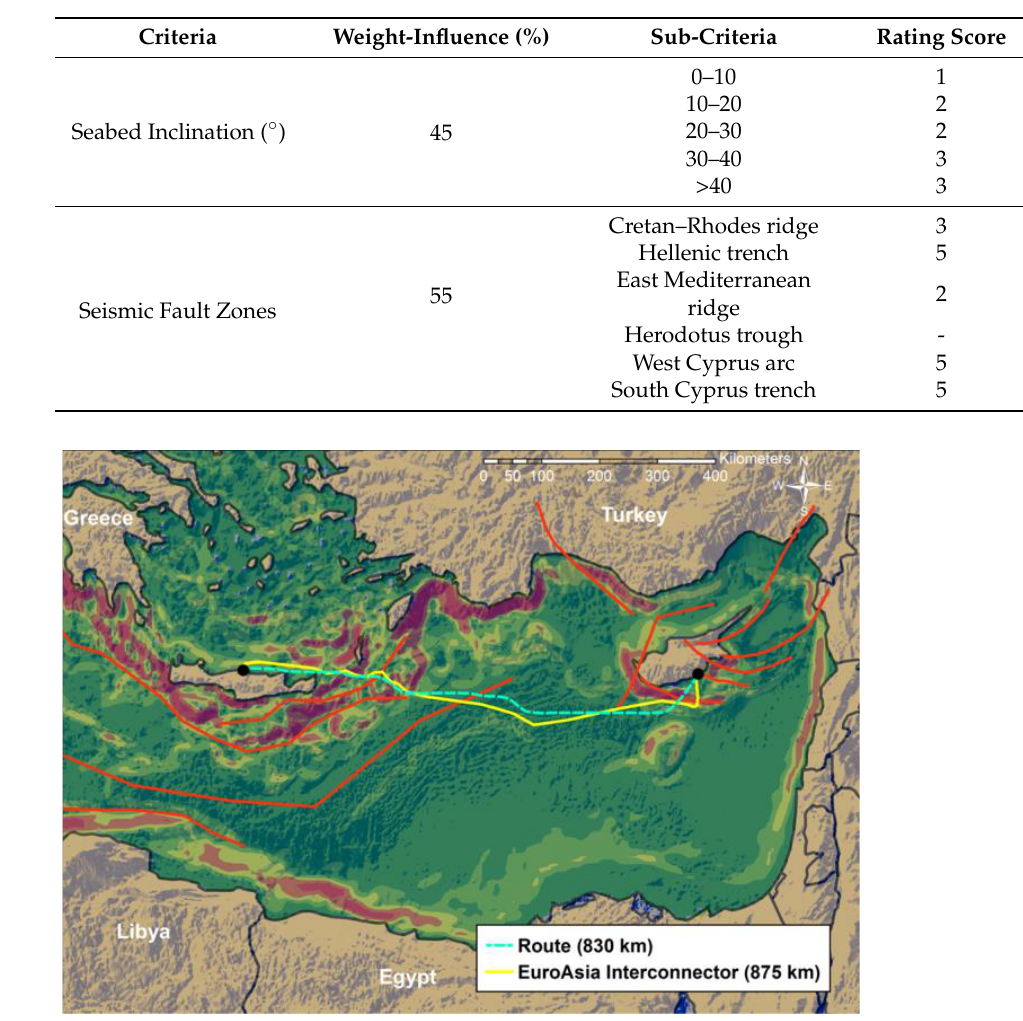
Table 1. Weight-influence and rating score of each of the adopted criteria and sub-criteria.